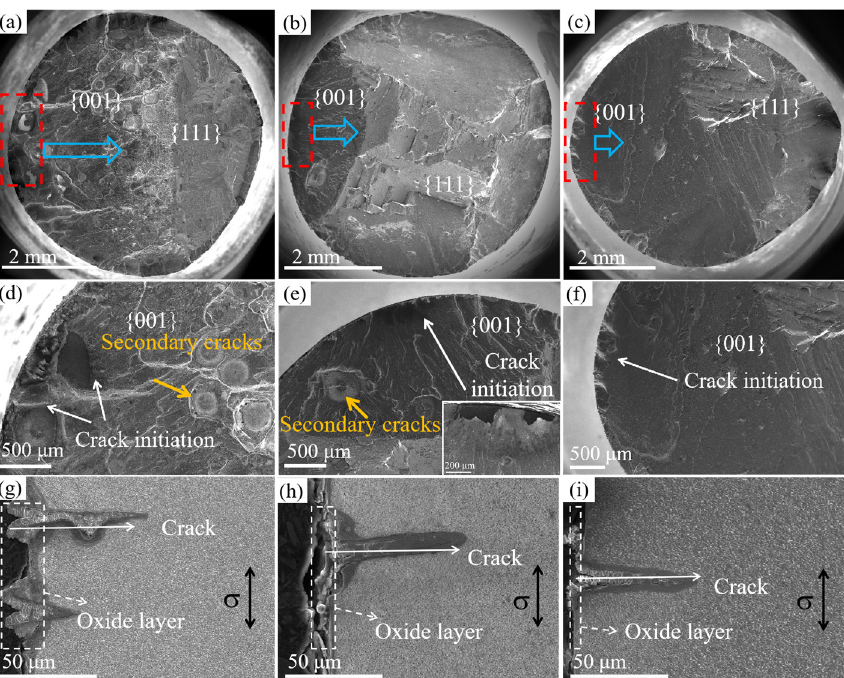
Figure 3. Surface morphologies and oxide layer near the surface of specimens after failure: ( a , d , g ); Δ ε Δ ε ∆ ε ∆ ε t /2 = 0.6%, ( b , e , h ); t /2 = 0.8%, and ( c , f ), and ( i ); t /2 = 0.6%, ( b , e , h ); t /2 = 0.8%, and ( c , f , i );